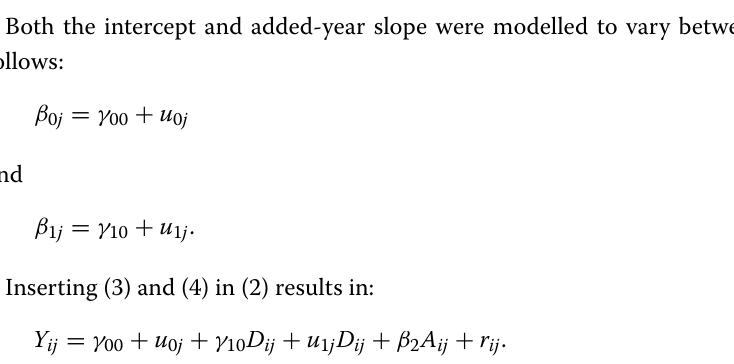
Regression discontinuity analyses with school‑level focus and socioeconomic school composition